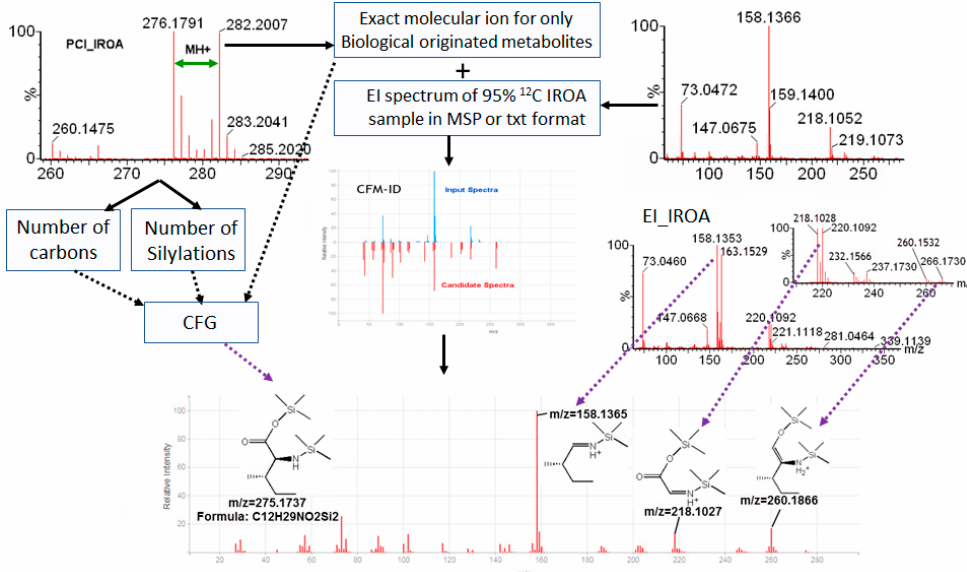
Figure 3. Expanded IROA metabolite identification procedure with in silico fragmentation. Isoleucine is used as an example here. Positive CI-IROA distinguishes unknown metabolites of biological origin from any artificial peaks, and identifies the molecular ion, number of carbons ( n ) in the metabolite from the dalton difference of the M 0 and M 0+n IROA peaks, and number of silylation groups attached to the metabolites. The exact mass of M 0 molecular ion is combined with the EI mass spectrum found from the 95% 12 C IROA sample as inputs into CFM-ID to search for potential IDs. The structural identity and its molecular ion can be validated/confirmed from the CI-IROA molecular ion, and the CFM-ID in silico EI fragmentation pattern can be confirmed from the IROA EI pattern.